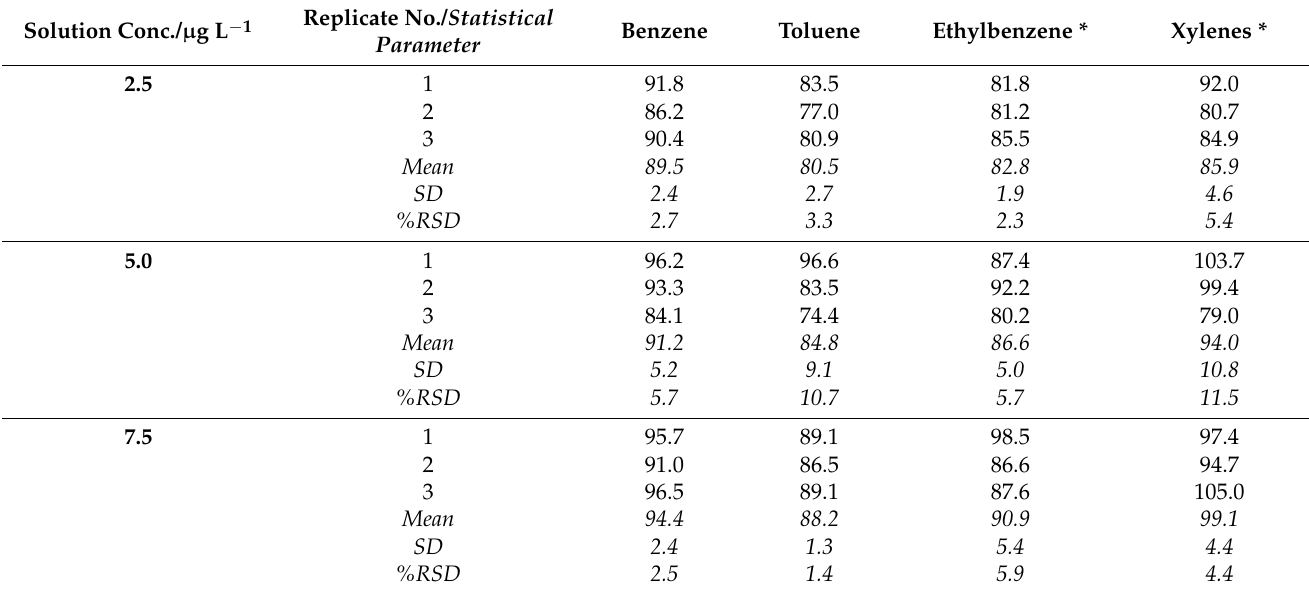
Table 11. Recovery data (%) for each of the triplicate measurements of 2.5, 5.0, and 7.5 µ g L − 1 BTEX spikes in drinking water (Cambridge, UK). Mean recovery, standard deviation (SD), and RSD are also shown.